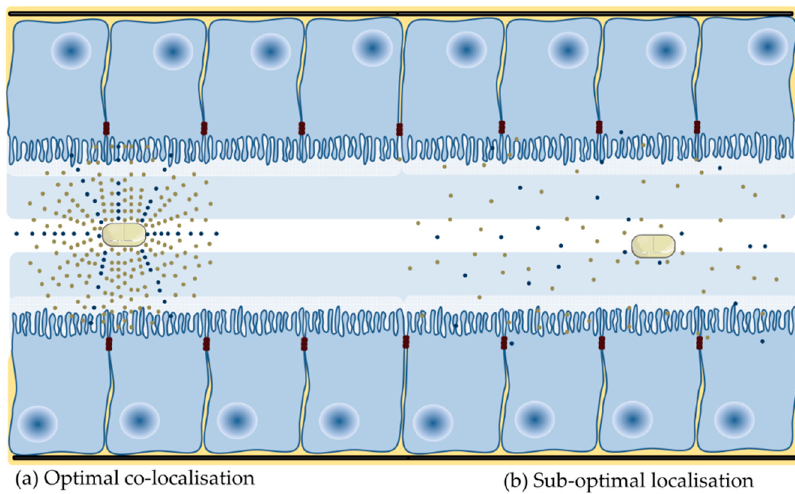
Figure 2. Presentation of PE and active at the small intestinal mucosa. ( a ) Co-localization of PE and active at the intestinal epithelium ensures that the PE is present at a high concentration and is present for long enough to alter barrier integrity. ( b ) A high local concentration of active provides the drive force for intestinal flux. A low release rate and more gradual dissolution of PE dosage forms, fast transit, spreading and dilution in luminal fluid and interaction with constituents of luminal fluid will impede optimal co-localization because the concentration of both are ultimately not high enough.